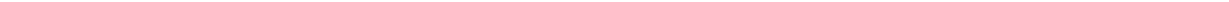
Fig. 3 NES (nuclear export sequence) in DVL is responsible for YAP traf fi cking. a The con fl uent MCF-7 cells were treated with Leptomycin B (LMB, 5ngml − 1 ) for 4 h, and endogenous YAP and DVL localization and abundance were determined by confocal microscopy (left panels) and immunoblotting (right panels). Scale bar, 10 μ m. b Schematic representation of the conserved NES and point mutant (NES-mutant-ASA) in DVL of human (h), mouse (m), and xenopus (x). c The MCF-7 cells were transfected with wt or NES-ASA mutant DVL3 and DVL-YAP localization was determined by confocal microscopy. The cells were serum-starved for 16 h before harvest. Scale bar, 5 μ m. d MCF-7 and 293 cells expressing inducible HA-tagged wt or NES-mutant (ASA) of DVL3 were treated with doxycycline, and YAP and DVL abundance were determined (left panels). YAP phosphorylation status in cytoplasmic and nuclear were transfected with fl ag-tagged YAP with NES-mutant or wt DVL3. The nuclear protein form NES-mutant transfectant was subjected